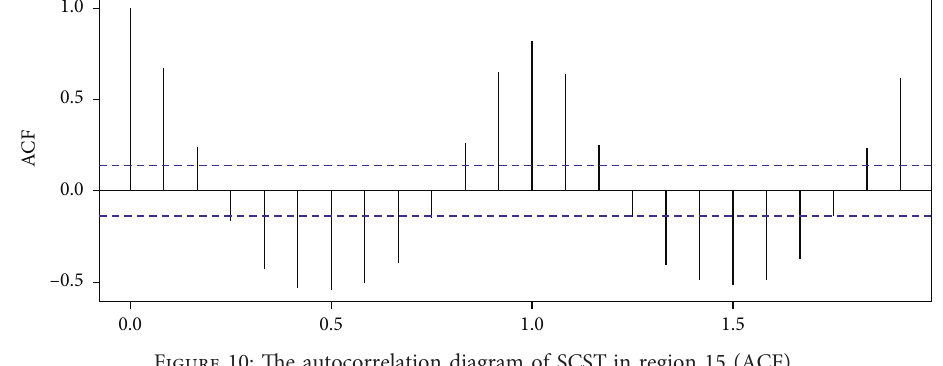
Figure 10: The autocorrelation diagram of SCST in region 15 (ACF).